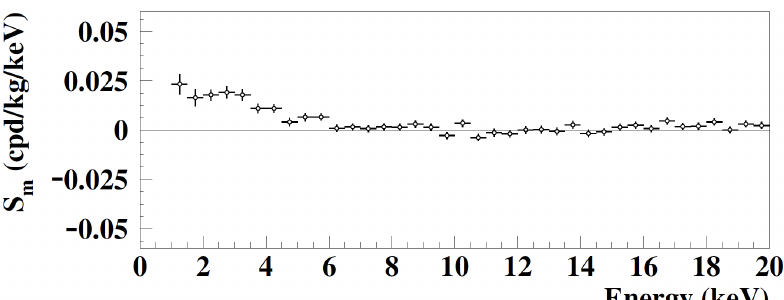
Figure 4. Modulation amplitudes, S m , for DAMA/NaI, DAMA/LIBRA–phase1 and DAMA/LIBRA– phase2 (total exposure 2.46 ton × yr). The data points below 2 keV belong only to DAMA/LIBRA– phase2. The energy bin ∆ E is 0.5 keV. The modulation is evident for the lowest energy data points, and S m ’s compatible with zero are present elsewhere. See text for comments. Reprinted with